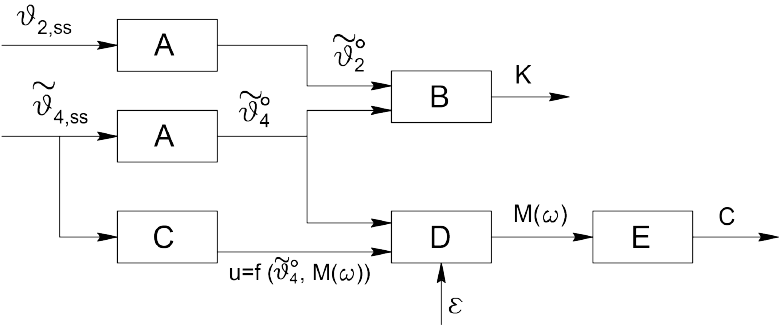
Figure 11. The complete control scheme for detecting the sample viscosity